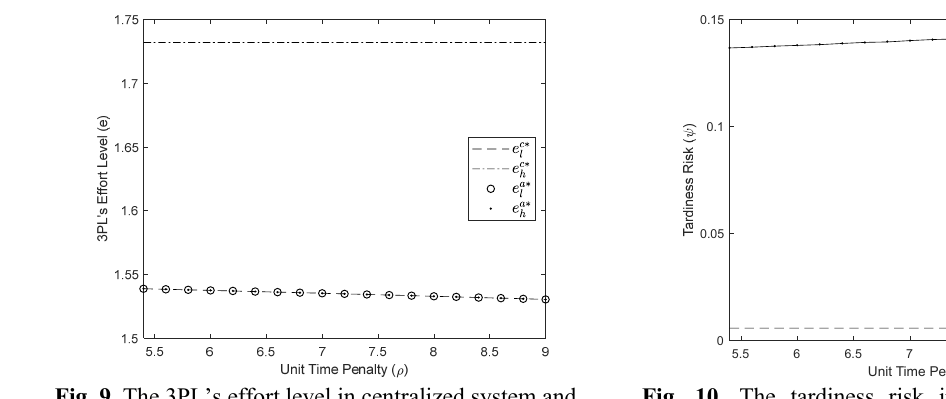
Fig. 9. The 3PL’s effort level in centralized system and asymmetric scenario